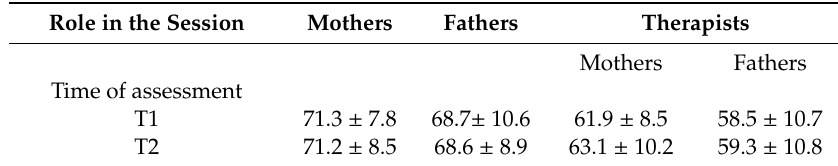
Table 1. Means ± Standard Deviations of the WAI-SF global scores for mothers, fathers and therapists, at T1 and T2.